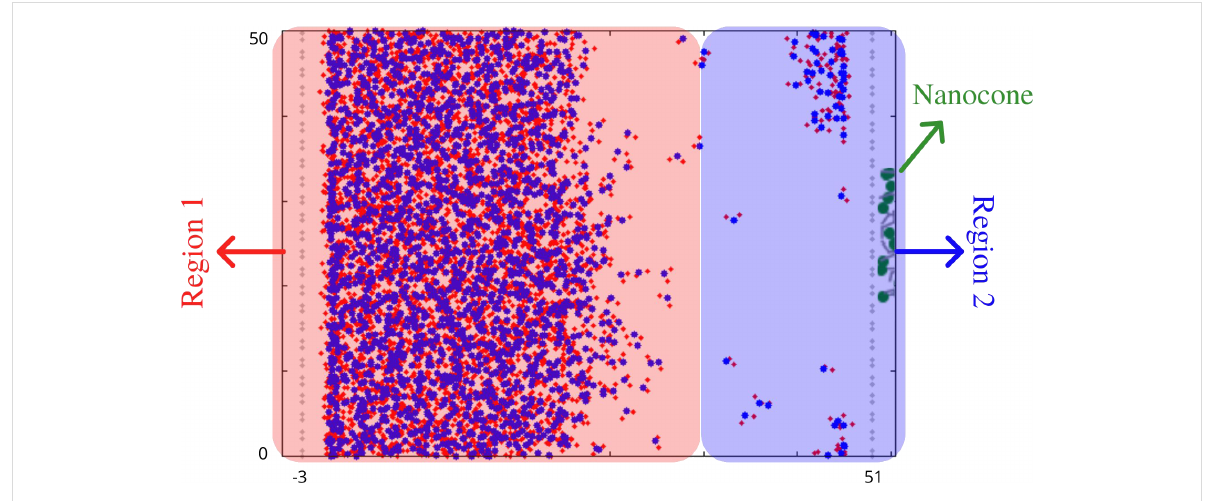
Figure 2: Part of the simulation box illustrating the two types of thermal control used in the simulation. The red area represents region 1 with a tem- perature dynamically changing between 800 and 300 K while the blue area is region 2 with a fixed temperature of 300 K.